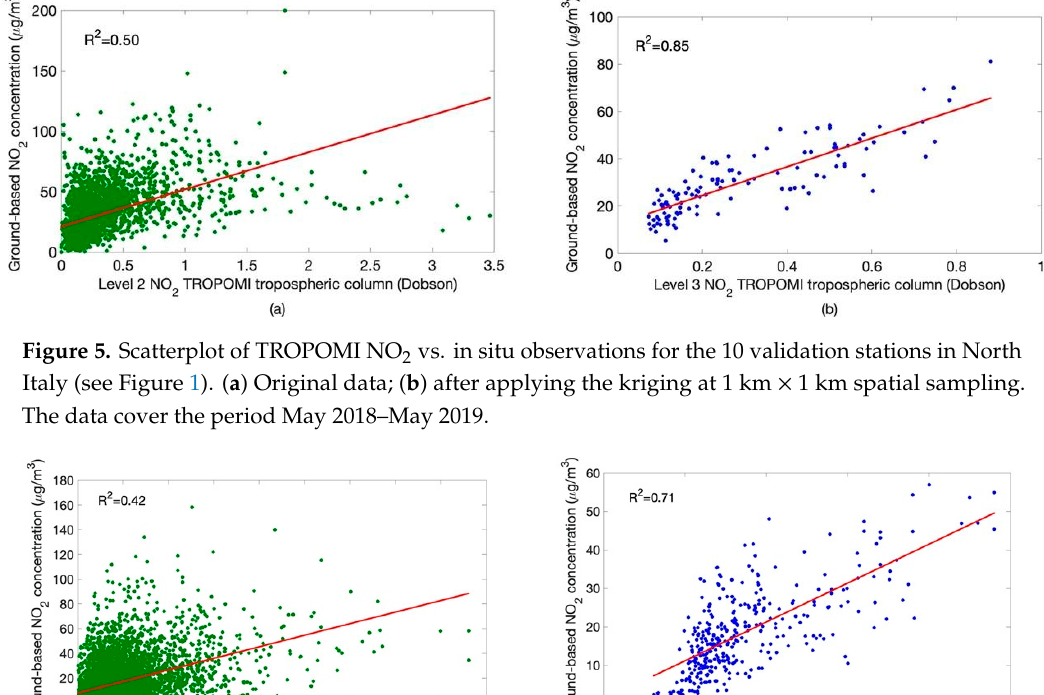
Figure 5. Scatterplot of TROPOMI NO 2 vs. in situ observations for the 10 validation stations in North Italy (see Figure 1). ( a ) Original data; ( b ) after applying the kriging at 1 km × 1km spatial sampling.